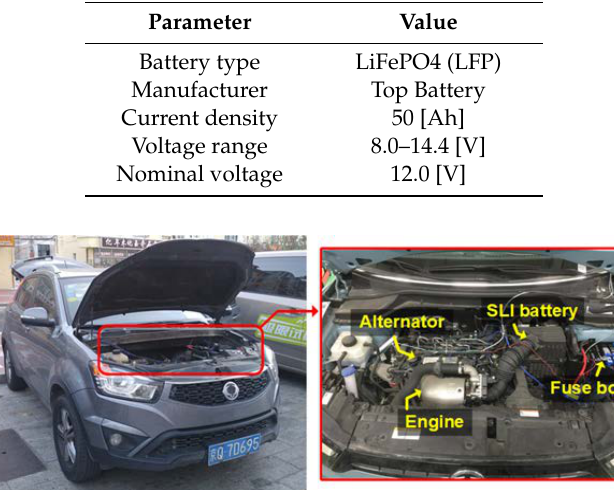
Figure 14. Setup for cranking experiments.